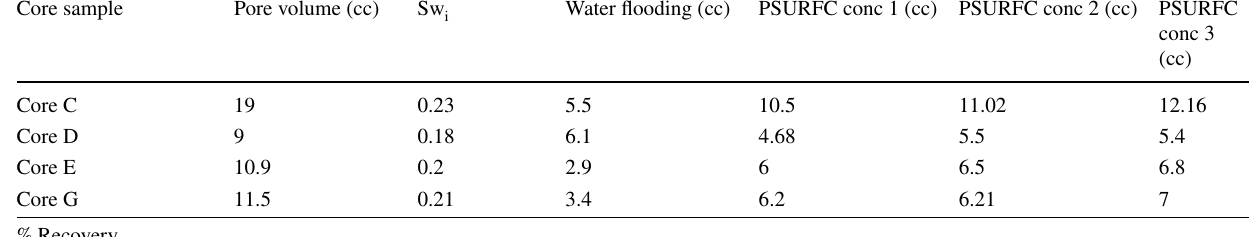
Table 8 Core flooding parameters and result for water and formulated polymeric PSURFC flooding @ 28 C Core